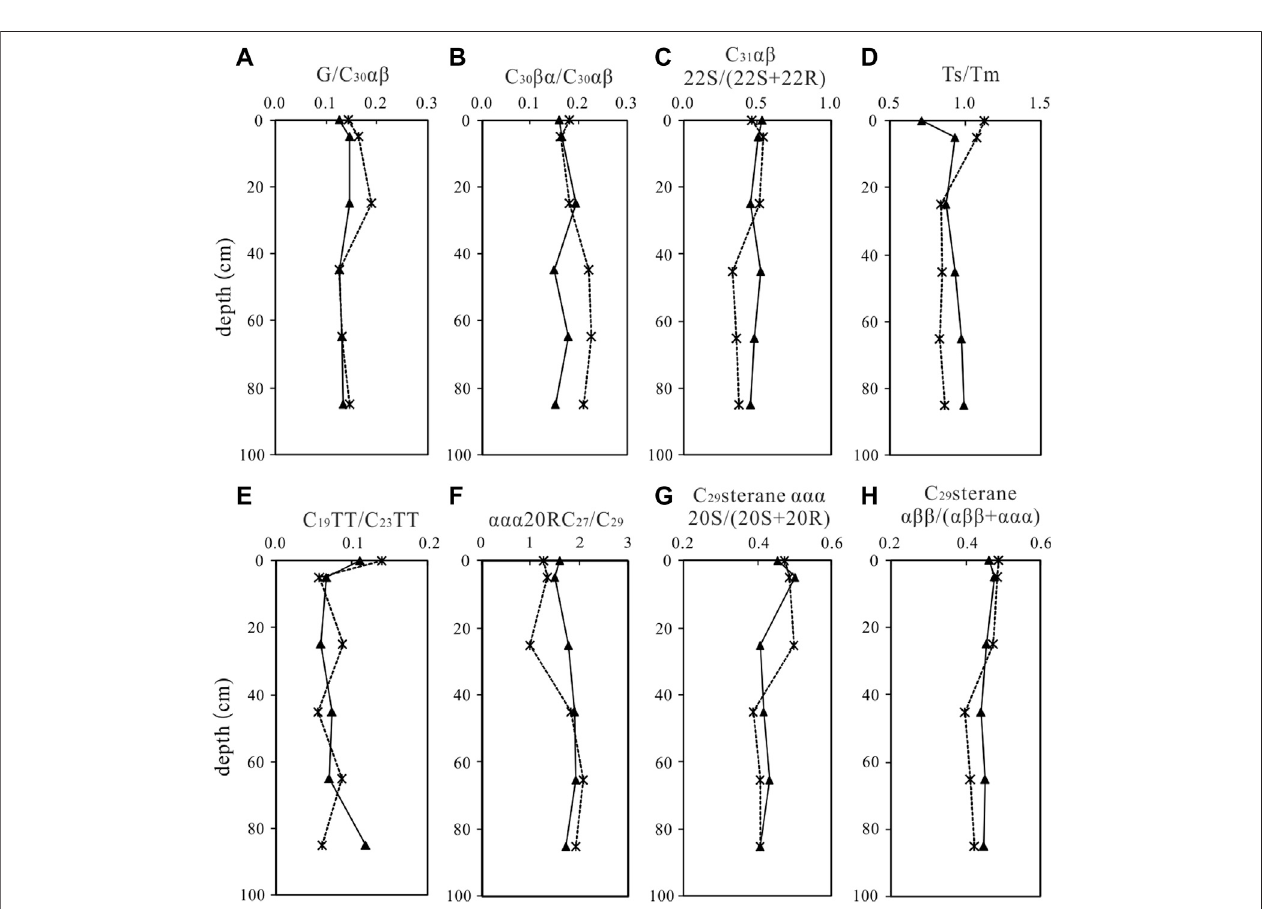
FIGURE7| Depthpro fi leofbiomarkerindexesincore29andcore45. (A) G/C 30 αβ , (B) C 30 βα /C 30 αβ , (C) C 31 αβ 22S/(22 S+22 R), (D) Ts/Tm, (E) C 19 TT/C 23 TT, (F) ααα sterane 20RC ααα 20S/(20 S + 20 R). amd (H) C αββ /( αββ + ααα 27 /C 29 , (G) C 29 sterane 29 sterane